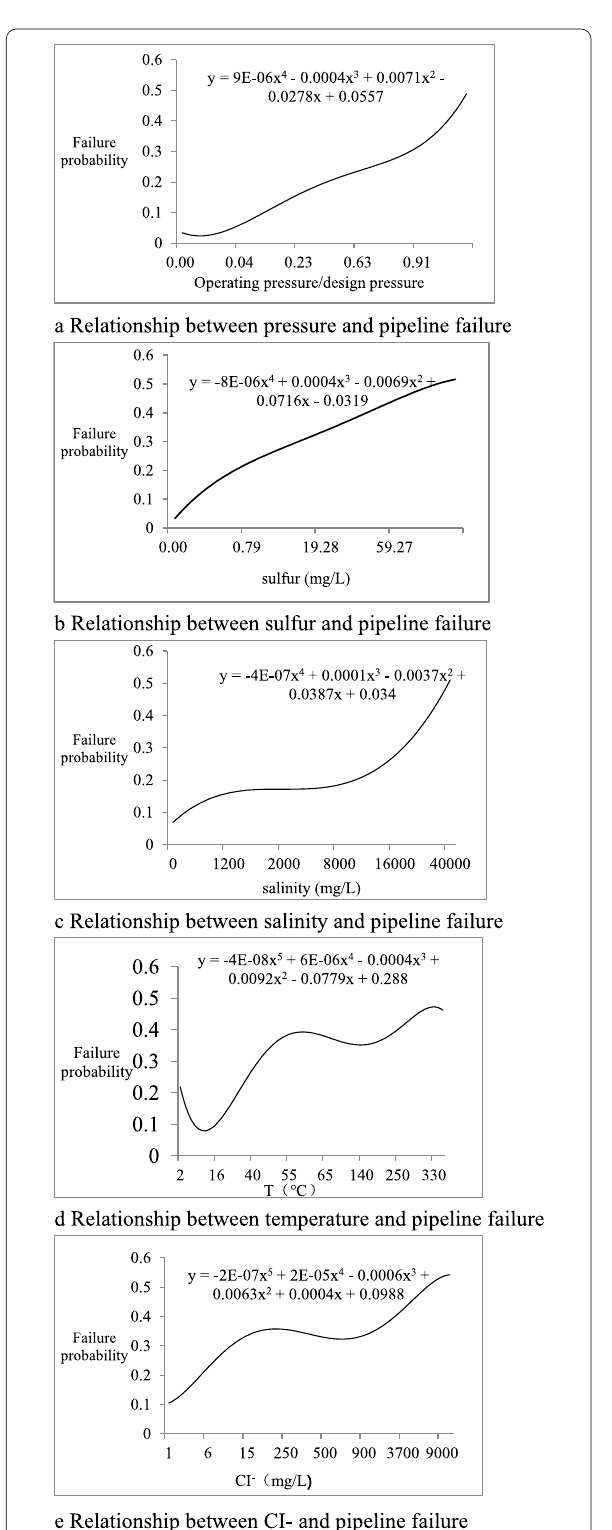
Fig. 3 Relationship between quantitative index and failure